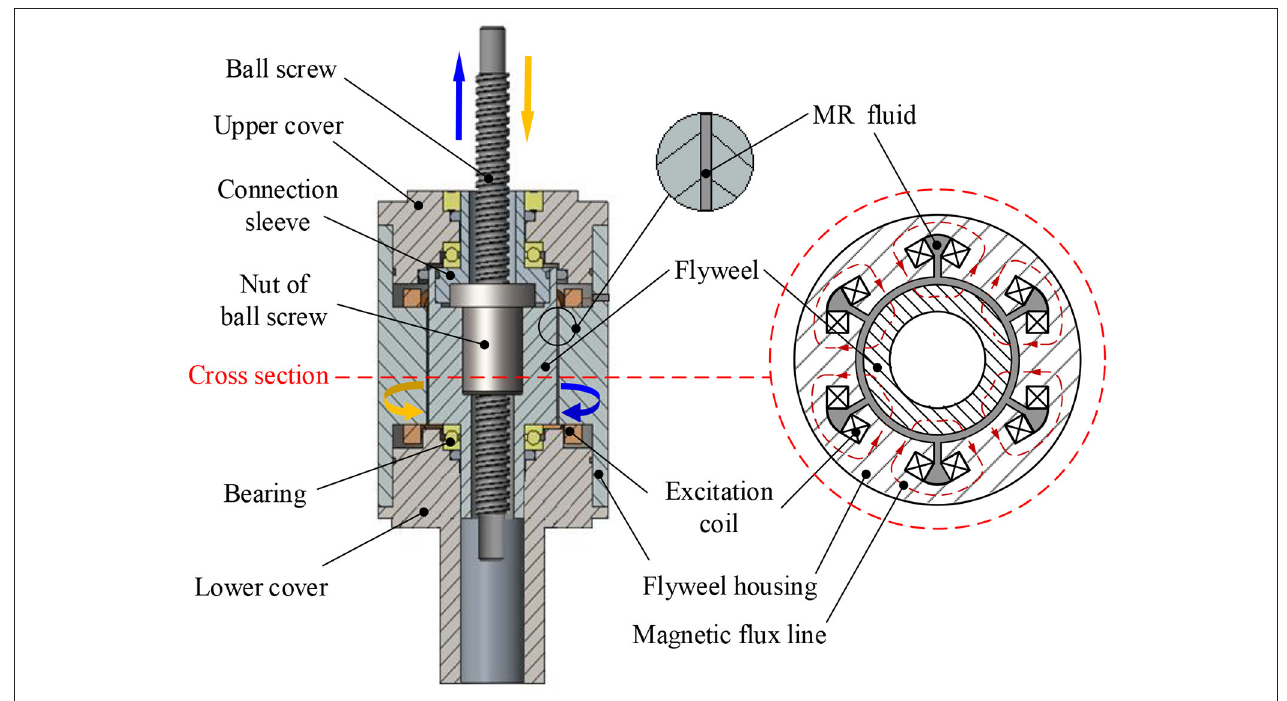
FIGURE 1 | Structural principle of the